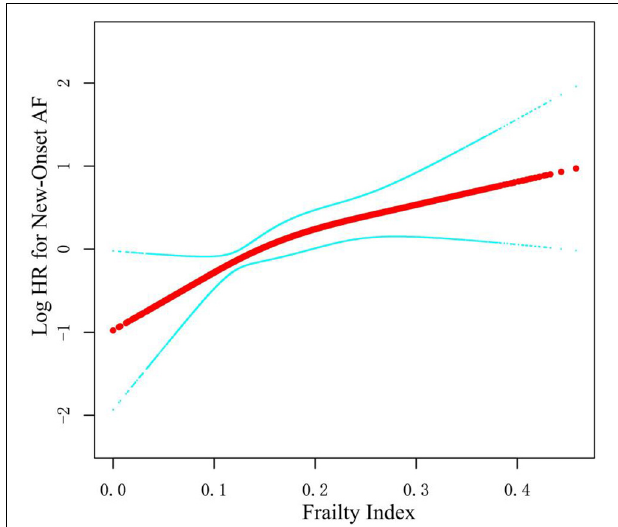
FIGURE 2 | Smooth spline curves of frailty index for the logarithm of hazard ratio of new-onset AF. Red line represents references for hazard ratios ( HR s), and blue lines represent 95% confidence interval ( CI ). Adjusted for all covariates in the Model